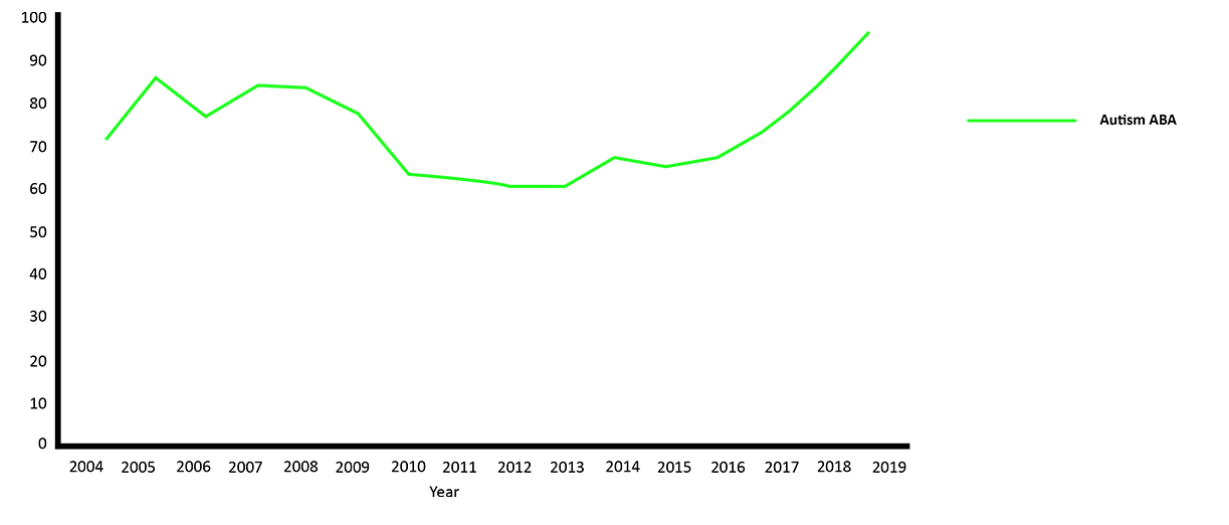
Figure 2. Google Trends analyses for web searches related to queries about applied behavior analysis (ABA) as an intervention for autism in the United States from 2004 to 2019.